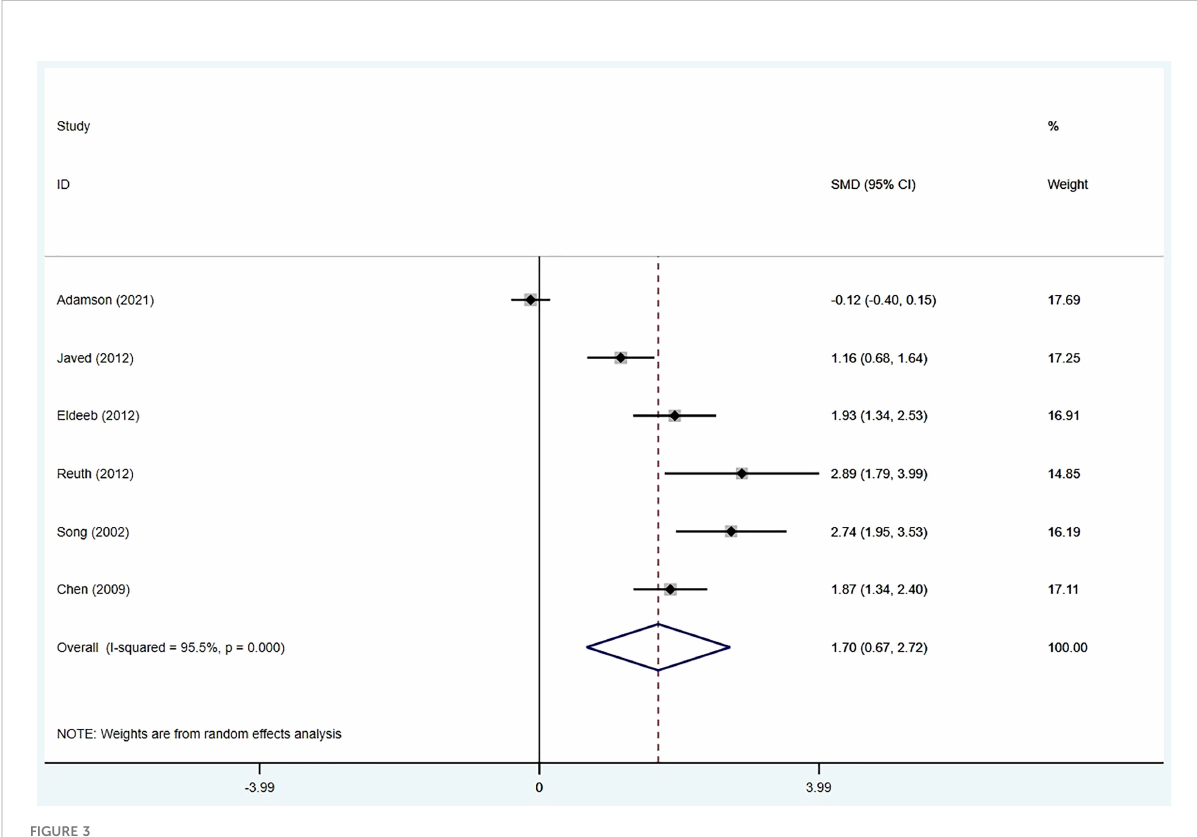
FIGURE 3 Forest plot for the results of median overall